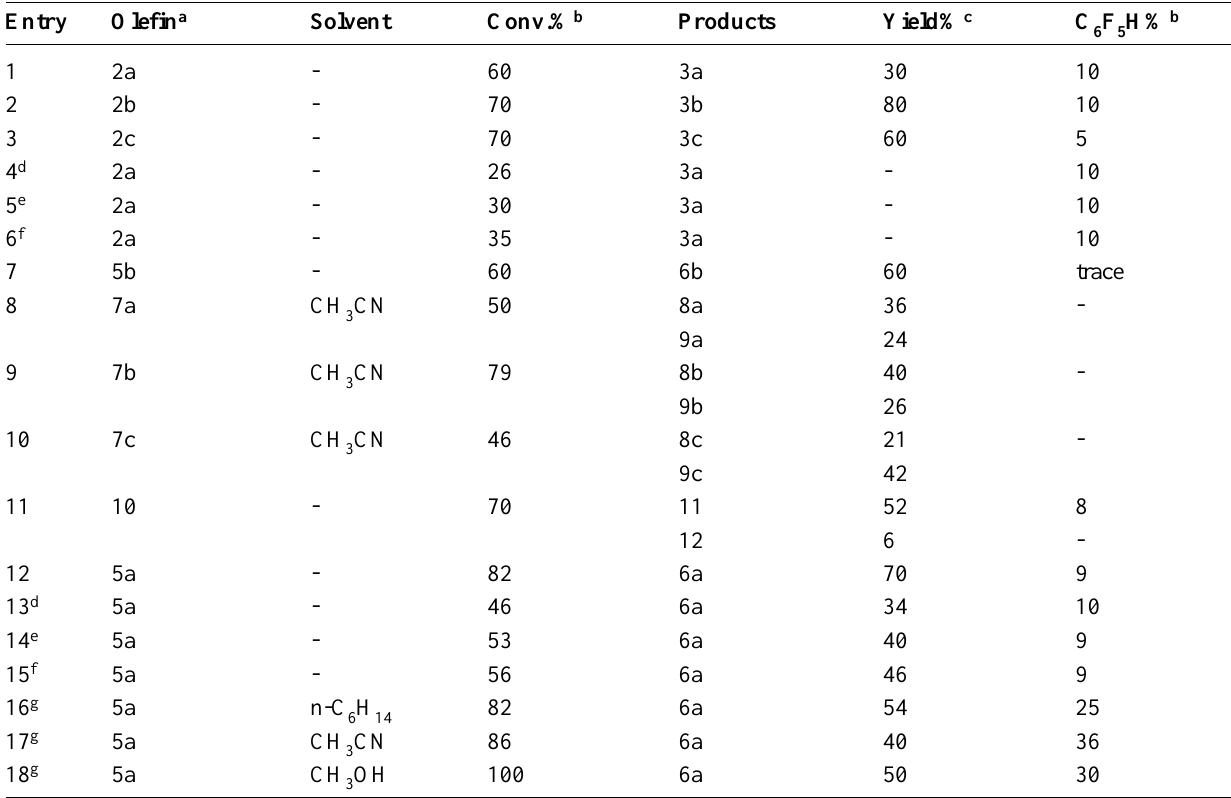
Table 1. Irradiation reaction of 1 with alkenes a